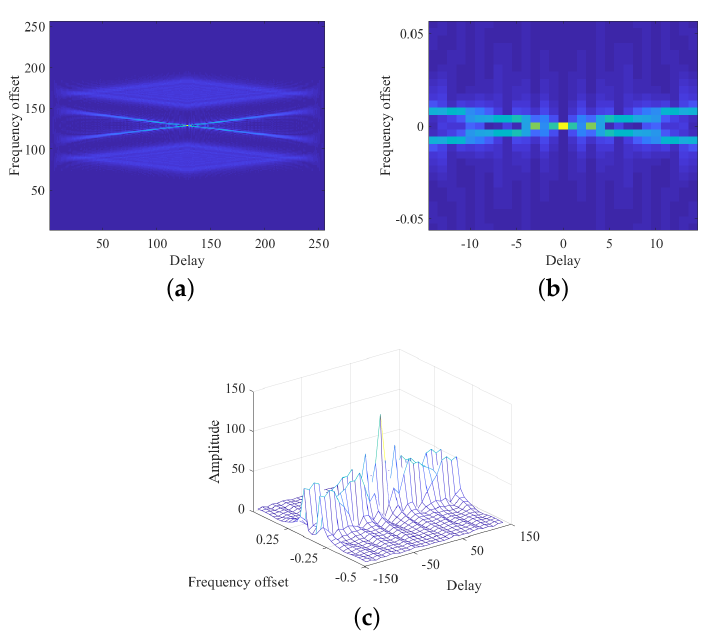
Figure 4. Comaprison of AF-RS and CS-MASK of LMF signal. ( a ) AF of LMF signal, ( b ) Two dimensional CS-MASK, ( c ) Three dimensional